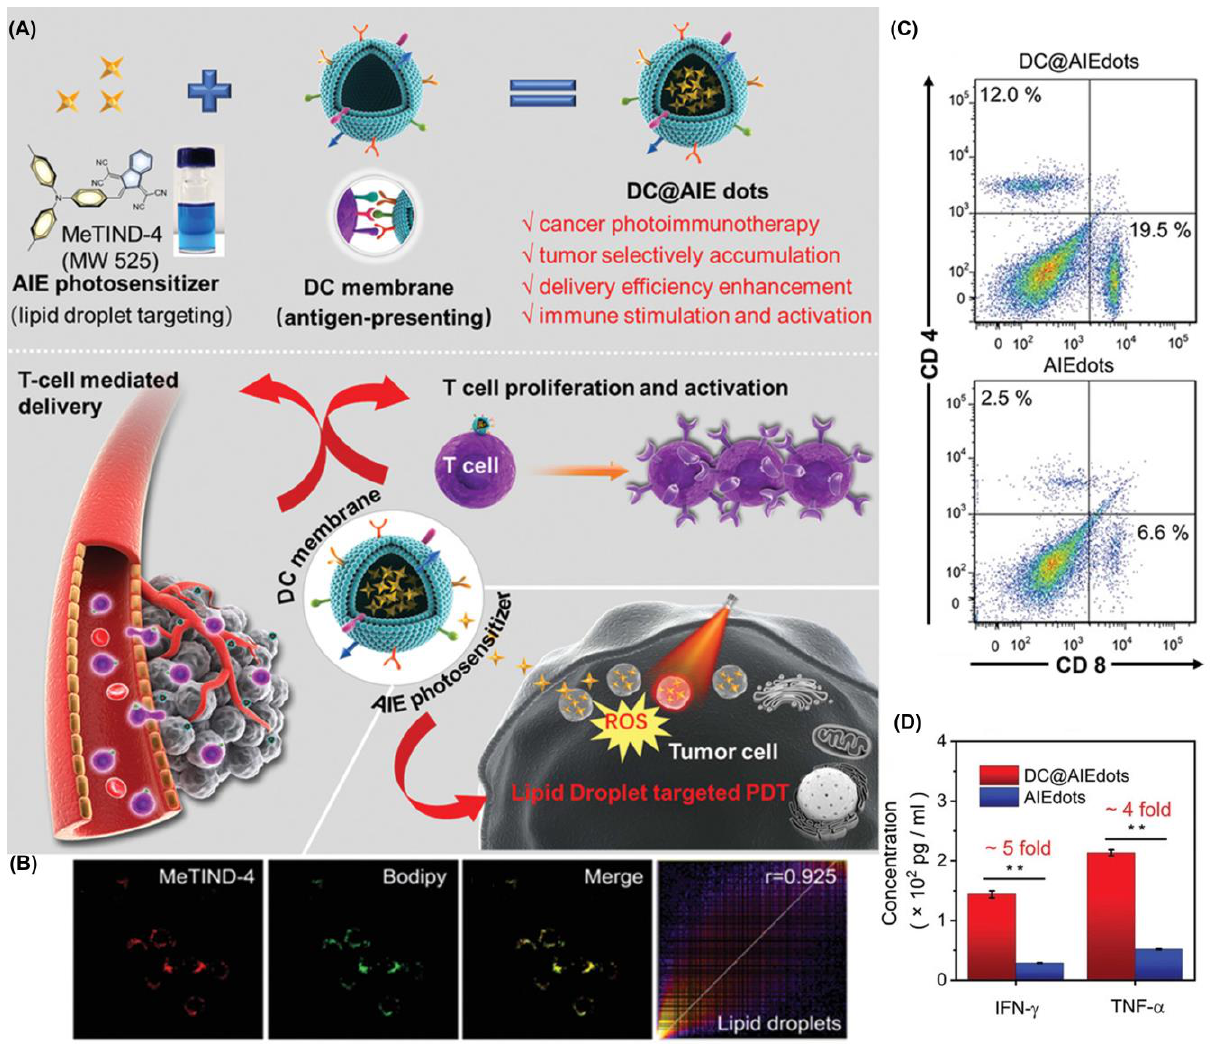
Figure 13. ( A ) Schematic illustration of chemical structures and in vivo photodynamic immunother- apy of DC@ AIEdots; ( B ) colocalization experiments of 4T1 cells stained with MeTIND-4; ( C ) flow cytometry analysis of tumor infiltrating CD8 + and CD4 + T cells; ( D ) concentration of proinflamma- tory cytokines TNF- α and IFN- γ . * p < 0.05, ** p < 0.01. Reprinted with permission from Ref. [114]. Copyright 2021 WILEY-VCH.